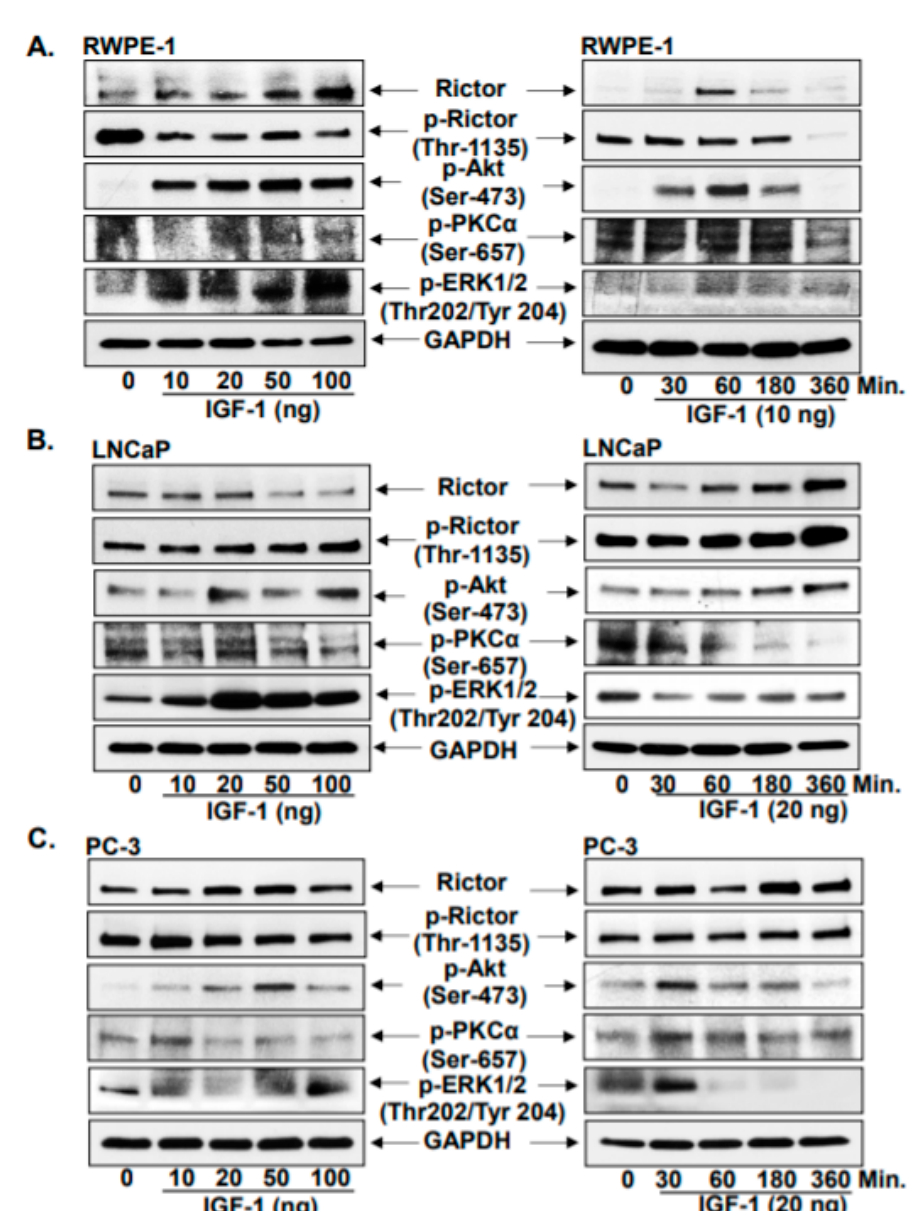
Figure 1. Growth factor (IGF-1) induced Rictor signaling cascade. Asynchronous ( A ) RWPE-1 normal prostate epithelial cells, ( B ) LNCaP (androgen sensitive), and ( C ) PC-3 (androgen refractory) cells were treated with IGF-1 in increasing concentrations (10, 20, 50, 100 ng) and time (30, 60, 180, 360 min) exposure, and later subjected to total cell lysate and western blot analysis. Protein resolved in SDS page gels were Rictor, p-Rictor (Thr-1135), p-AKT (Ser-476), p-PKC α (Ser- 657), and p-ERK1/2 (Thr202/Tyr 204). Lanes mentioned as ‘0’ are PBS control-treated cells. For protein, control blots were stripped and reprobed with GAPDH.